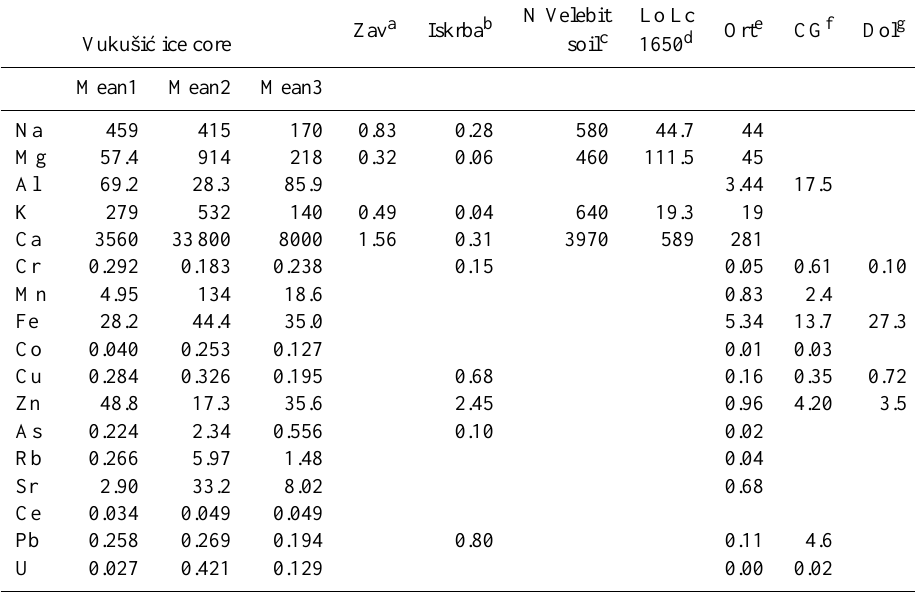
Table 2. Average elemental concentrations in the three stratigraphic units of the Vukuši´c ice core and in the local precipitation, soil water, an Italian cave ice and three Alpine snow/firn/ice records. Values are in ngg − 1 . Depth ranges of the three stratigraphic units: Mean 1: